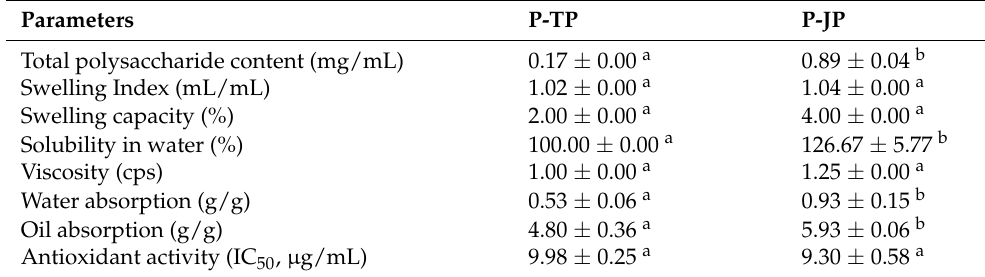
Table 4. Physicochemical properties and antioxidant activity of pumpkin polysaccharides.